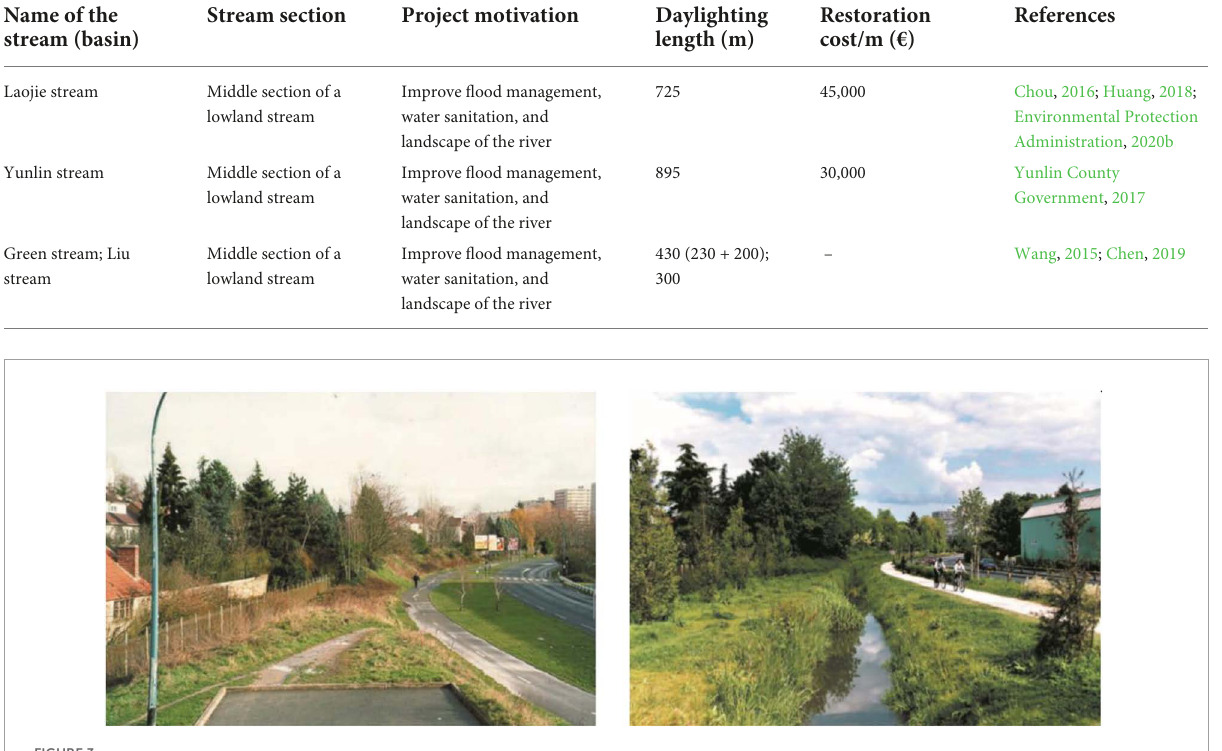
FIGURE3 The Bièvre before (date) and after (date) daylighting. Photograph: Hervé Cardinal- SIAVB.